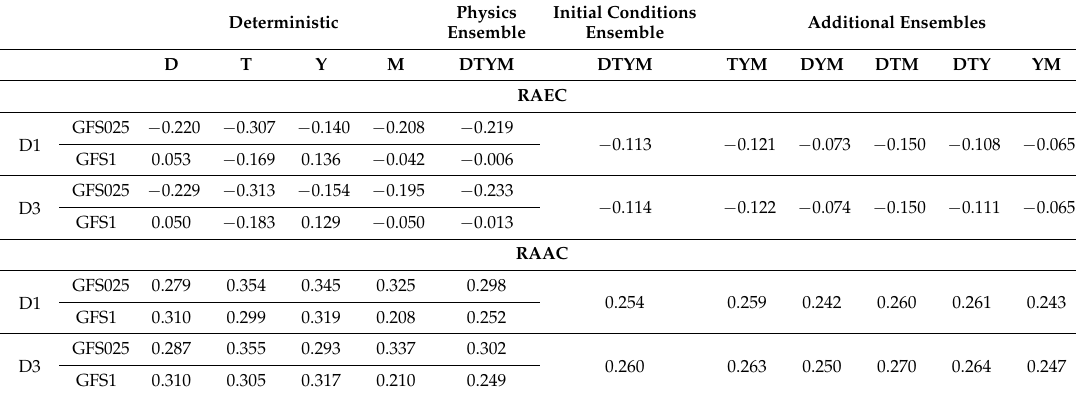
Table 6. Integrated validation: RAEC and RAAC. All 32 model configurations are shown for domain resolution, GFS resolution, microphysics parameterizations, and various ensembles chosen. Best three performers for each index are shaded. Physics Initial Conditions Deterministic Ensemble